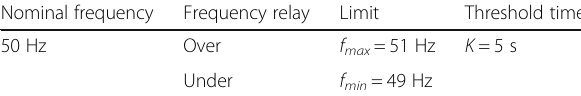
Fig. 6 The computational model of the digital OUFR